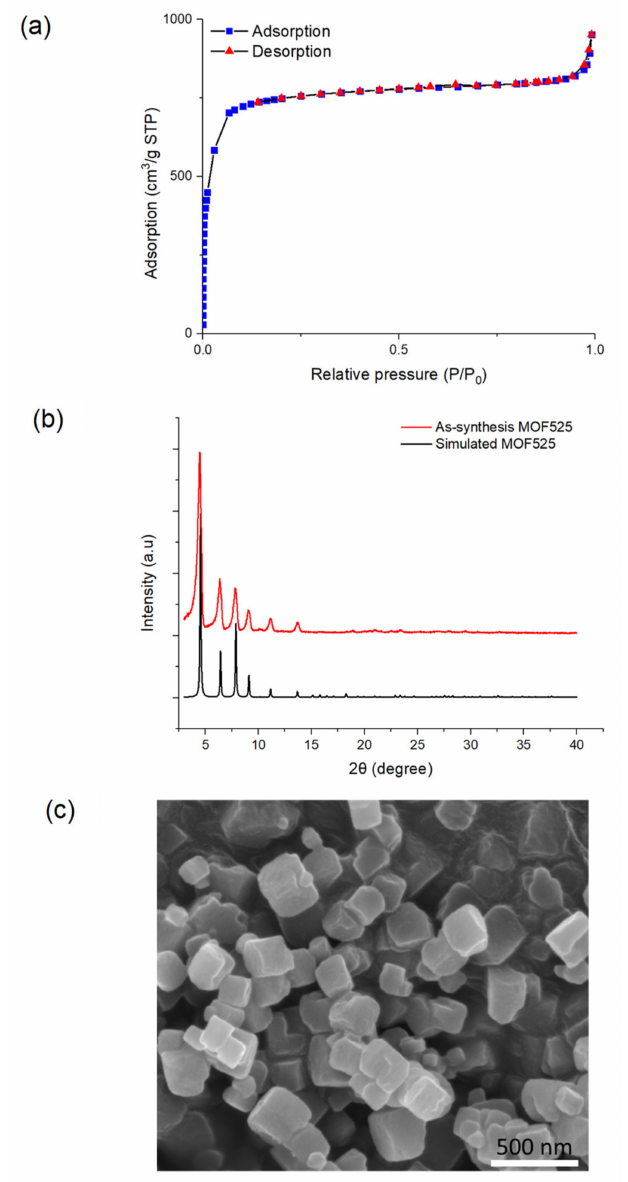
Figure 2. MOF525 characterizations by ( a ) nitrogen adsorption-desorption isotherms, ( b ) XRD, and ( c )